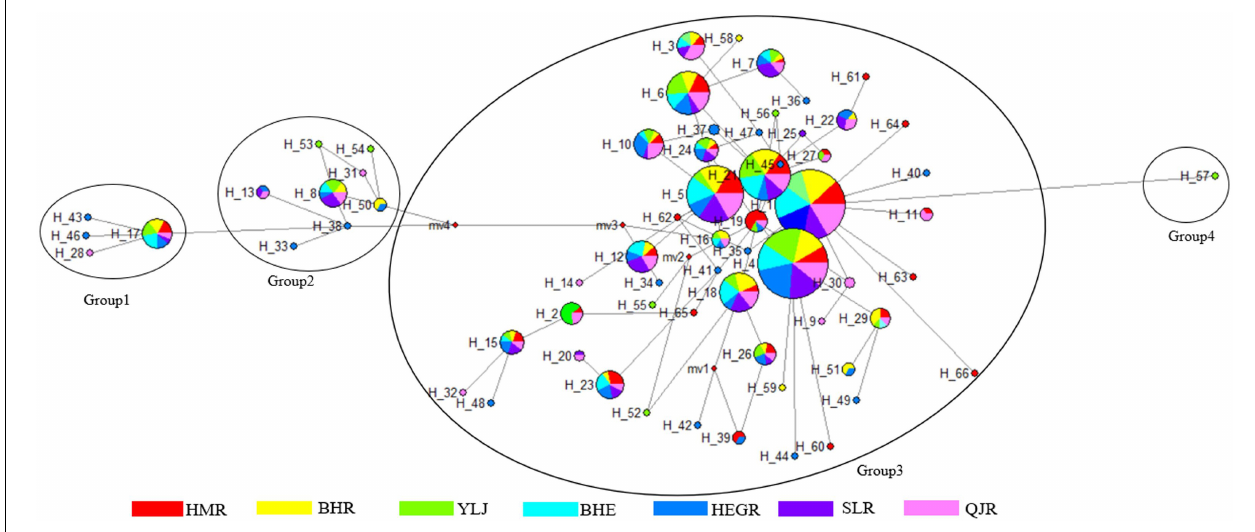
FIGURE 3 | Haplotype network of D-loop region in G. przewalskii . Each circle represents a haplotype and its size is proportional to the haplotype frequency. The numbers indicate the name of the haplotypes and the colors represent geographic locations.